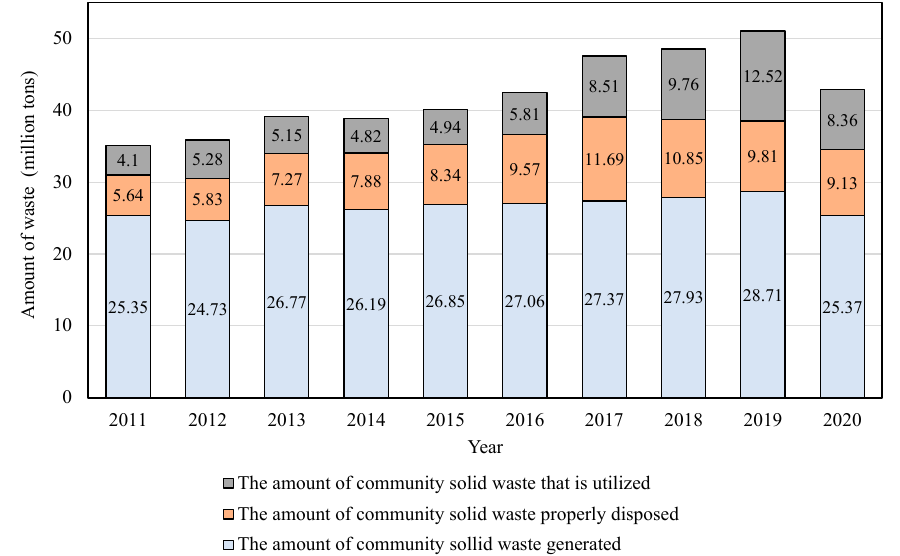
Figure 3. The amount of waste generation and utilization in Thailand [7,19].